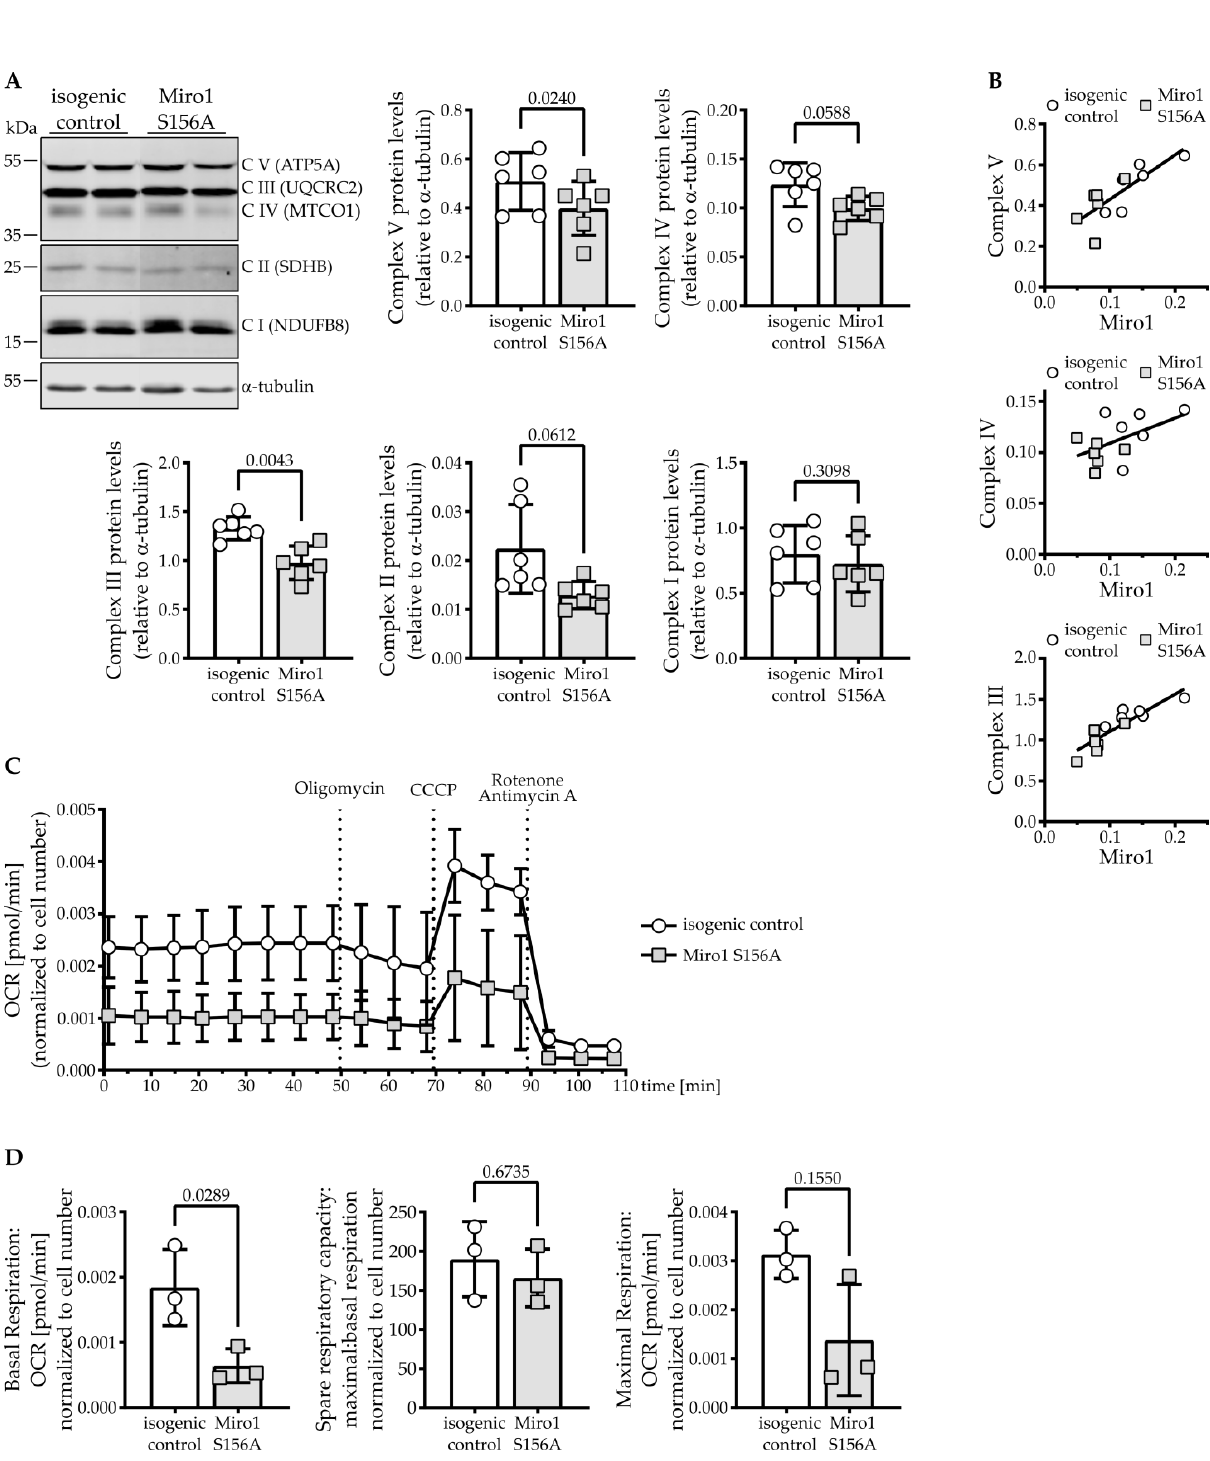
Figure 3. Miro1 S156A reduces mitochondrial respiration in hDaNs. ( A ) Representative Western blot showing complex V/IV/III/II/I in hDaN lysate. Quantification of the intensity of bands normalized to α -tubulin. Error bars depict standard deviation (n Diff = 6); paired t test, two-tailed. ( B ) Correlation of Miro1 protein levels to complex V/IV/III protein levels in hDaN lysate (n Diff = 6). ( C ) Respiratory analysis of mitochondrial oxygen consumption in hDaNs. Neurons were challenged with Oligomycin, CCCP, and rotenone with antimycin A at the indicated times. Oxygen consumption rate was normalized to the number of cells seeded. Error bars indicate standard deviation (n Diff = 3). ( D ) Basal respiration, spare respiratory capacity, and maximal respiration calculated from respiratory analysis. Error bars indicate standard deviation (n Diff = 3); paired t test,